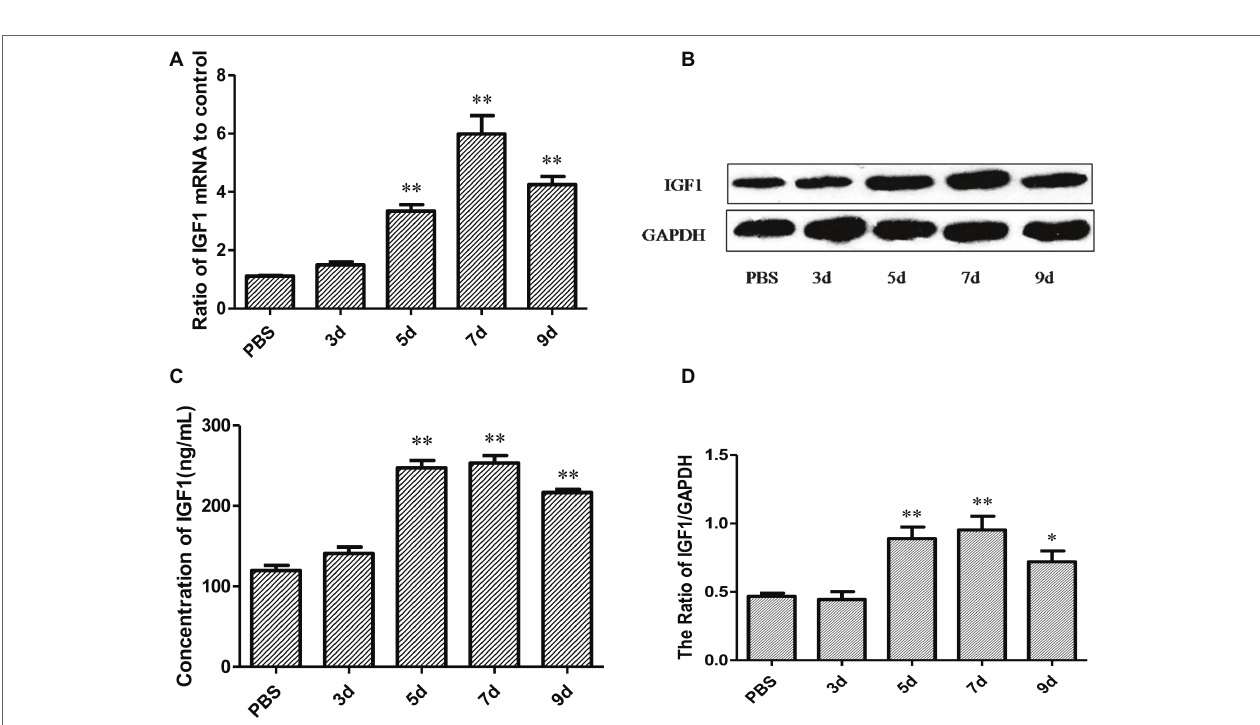
FIGURE 3 | IGF1 expression is upregulated in BALB/c mice infected with IAV PR8. (A) Changes in the level of IGF1 mRNA over time in the lung tissue of BALB/c mice infected with PR8 (50LD 50 ); (B) changes in the level of IGF1 protein over time in the lung tissue of BALB/c mice infected with PR8 (50LD 50 ); (C) grayscale analysis of Figure 3B, and plotted as the ratio of the integrated density of IGF1/GAPDH; and (D) changes in the level of IGF1 mRNA expression over time in the serum of BALB/c mice infected with PR8 (50LD 50 ). The lung and serum sample were mixed from six mice in the group. Data were the means ± SD from three independent experiments. ** p < 0.01 vs. PBS group by t test.